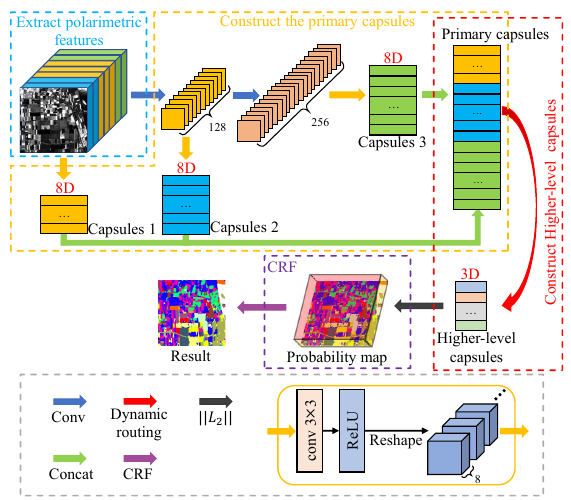
Figure 1. The architecture of the proposed classification